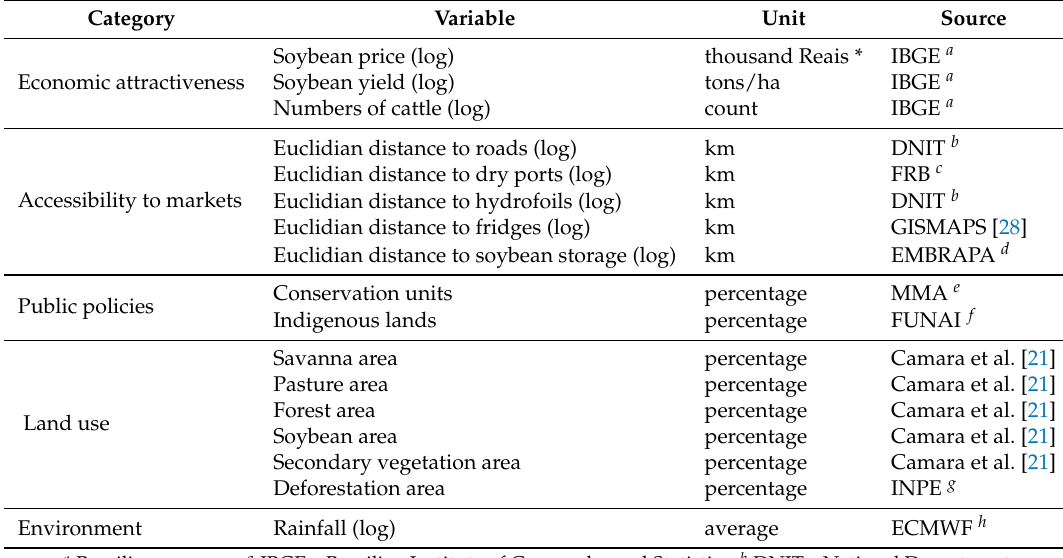
Table 1. Potential explanatory variables of soybean and pasture